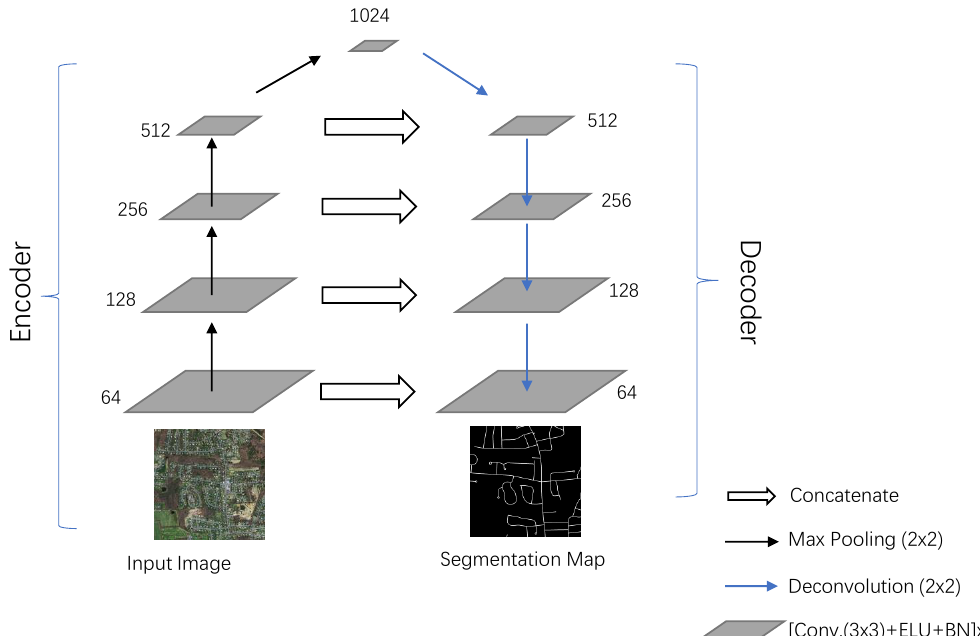
Figure 2. A brief illustration of the improved U-net structure: The left-side blocks form the encoder part, in which the channels of the feature maps are doubled from 64 to 1024. The blocks on the right side constitute the decoder part, in which the resolution of the feature maps is gradually recovered by upsampling and gathering information from the encoder feature maps. Finally, a binary segmentation map that has the same resolution as the input image is produced as the road extraction